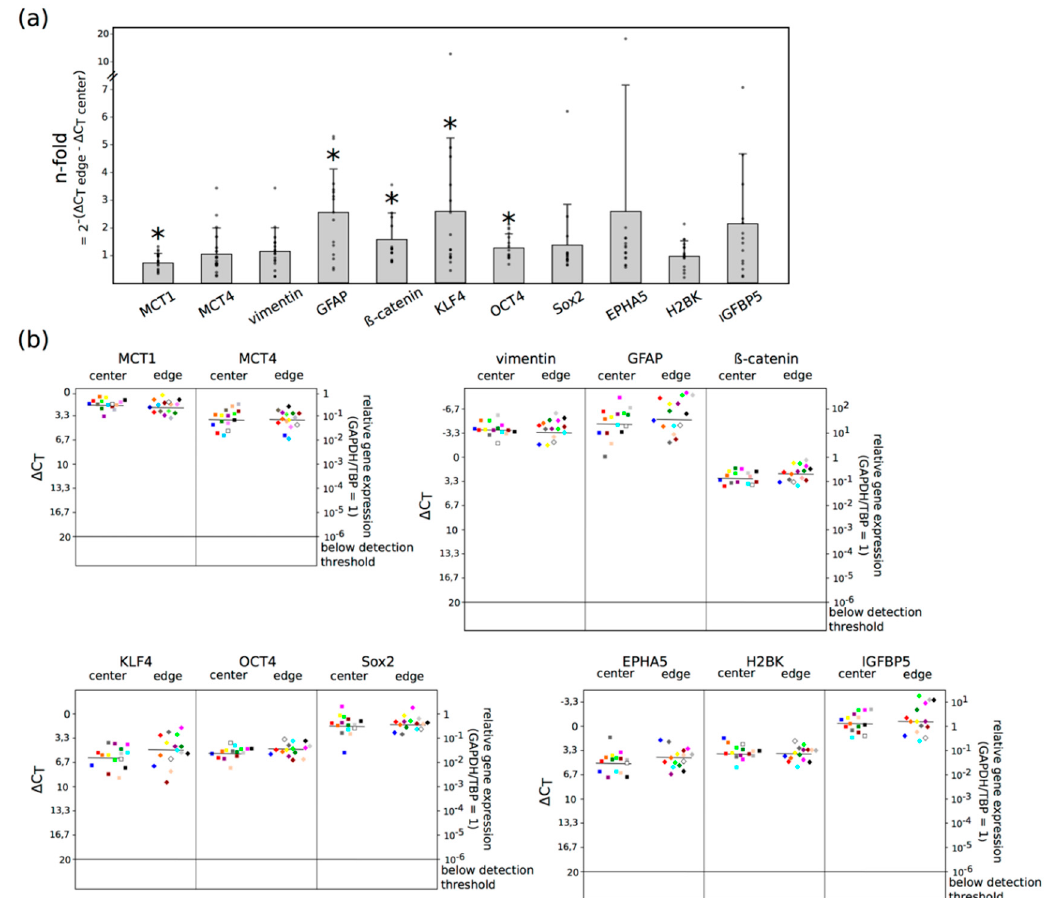
Figure 3. Expression of MCT (monocarboxylate transporter) 1, MCT4, EMT (epithelial to